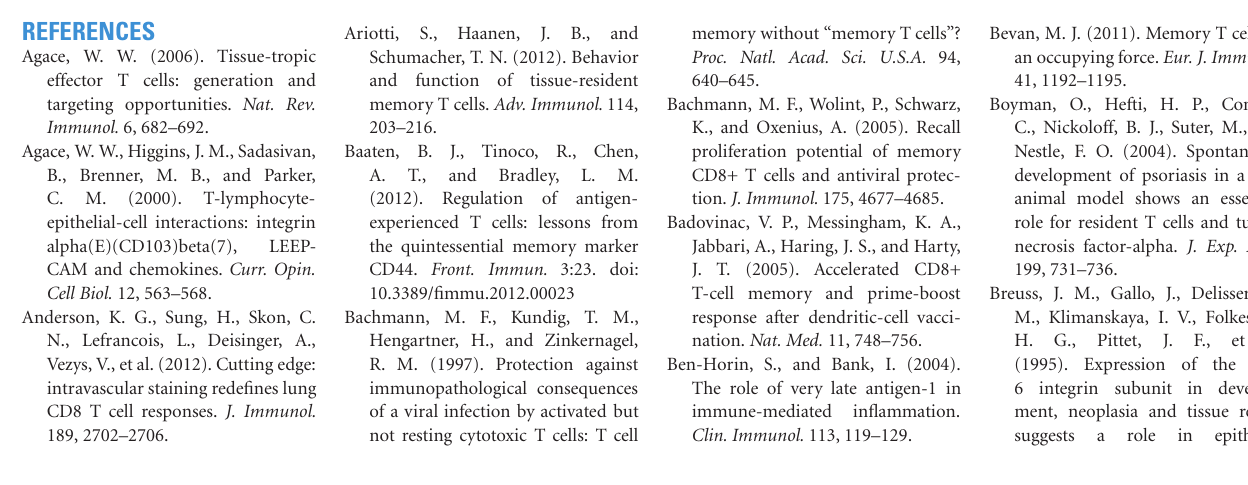
(B) Repeated immunizations in different skin sites result in elevated numbers of T RM cells in both targeted and remote areas of skin. This strategy has the potential to generate global T RM -cell-mediated immunity against skin infection, although this remains to be formally